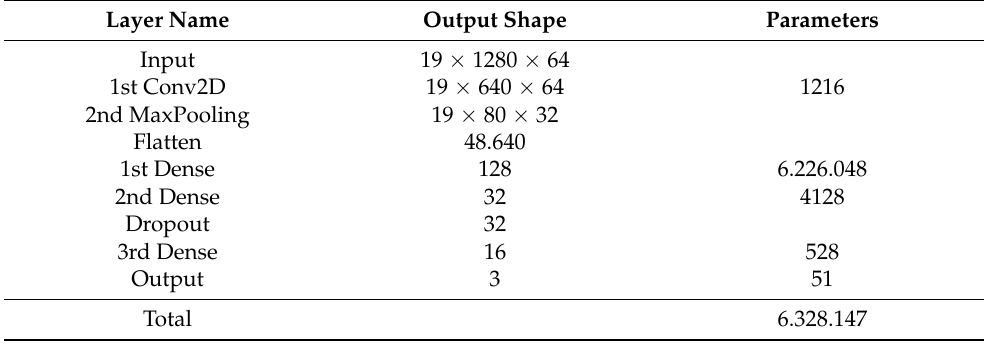
Table 1. The proposed CNN architecture’s total number of parameters. The CNN consists of two convolutional layers (+ReLu), two max pooling layers, three fully connected layers, one dropout layer, and a sigmoid layer that performs three-way classification tasks. Layer Name Output